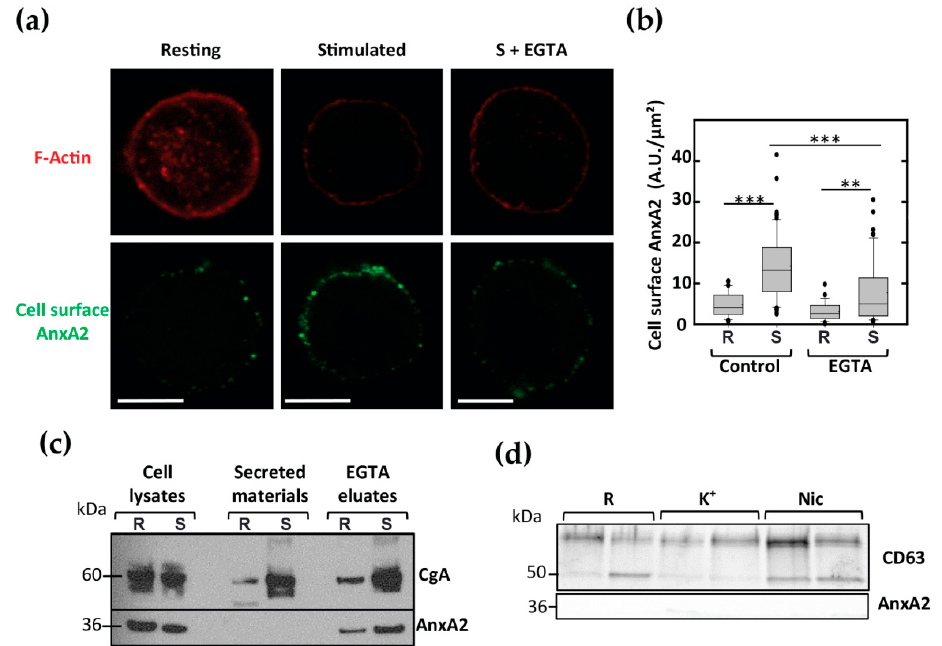
Figure 1. Annexin A2 (AnxA2) is present on the outer face of the plasma membrane of stimulated chromaffin cells. ( a ) AnxA2 labeling at the surface of chromaffin cells in the resting condition (Resting), stimulated with 20 µM nicotine without (Stimulated) or after washing with calcium-free Locke’s solution containing 20 mM EGTA (Stimulated + EGTA). Anti-AnxA2 antibodies were revealed with Alexa Fluor ® 488-conjugated anti-rabbit antibodies and F-actin with TRITC-phalloidin.